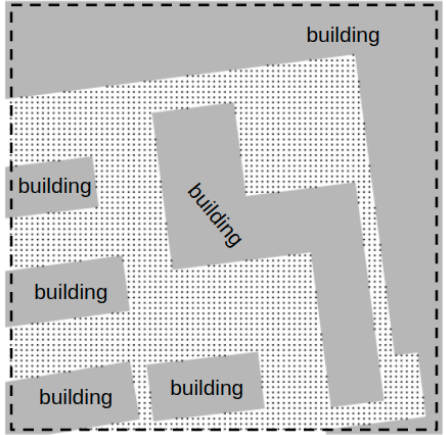
Figure 2. Example of an area to be covered by a D-mMIMO deployment. The dashed line indicates the border of the coverage region. The black dots are the potential user locations that need to be covered by the signal, hence a discretization of the continuous area into a grid. The D-mMIMO system has multiple APs. The black dots next to buildings also indicate the potential locations for deploying the